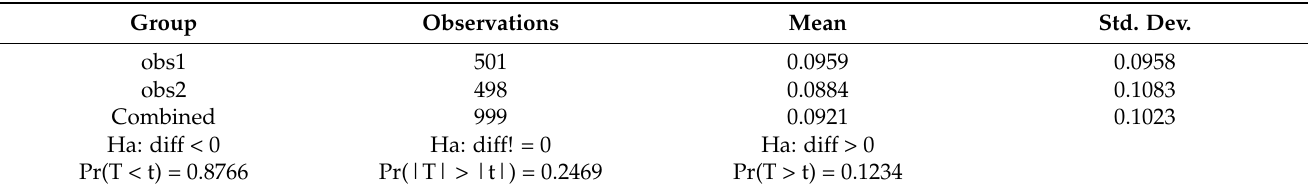
Table 5. Robustness test 1.